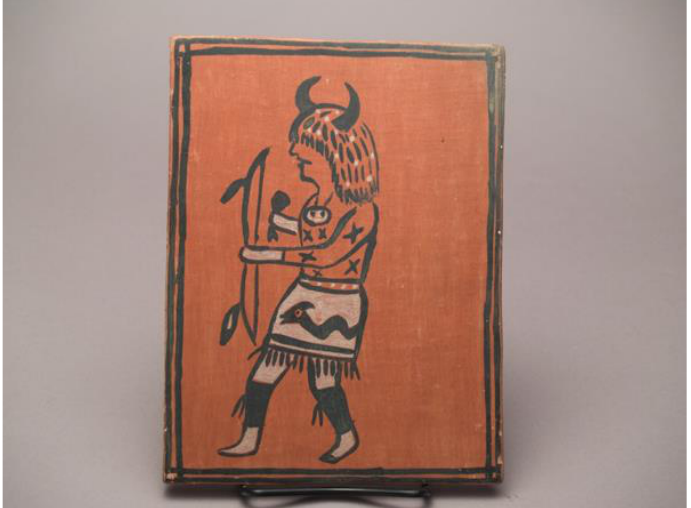
Figure 2. Crescencio Martinez, Tile, c. 1917–1918. Courtesy of the Museum of Indian Arts and Culture, Laboratory of Anthropology, Santa Fe, NM, 18737/12.